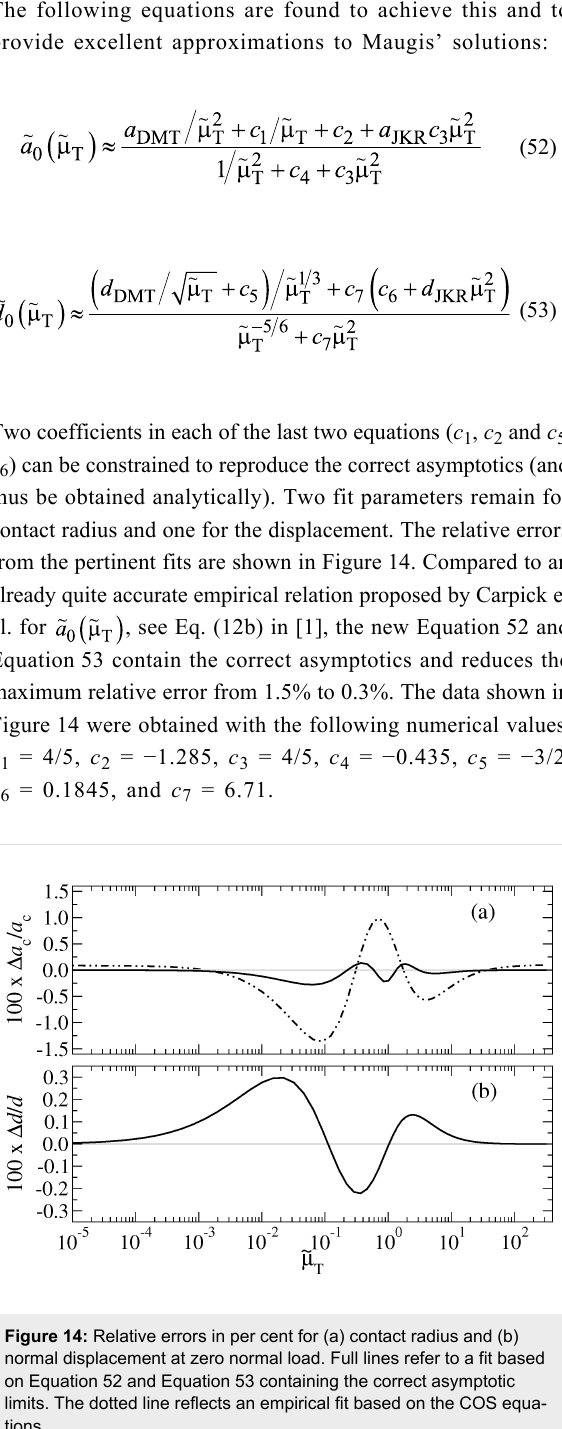
Figure 14: Relative errors in per cent for (a) contact radius and (b) normal displacement at zero normal load. Full lines refer to a fit based on Equation 52 and Equation 53 containing the correct asymptotic limits. The dotted line reflects an empirical fit based on the COS equa- tions.